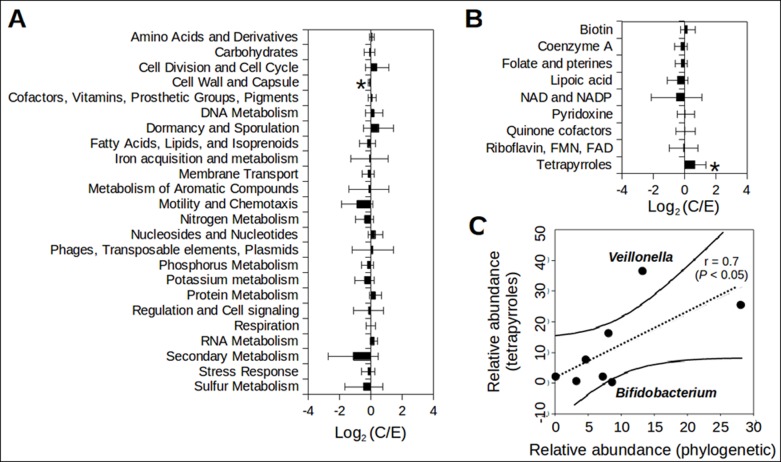
Metabolic pathways differentially abundant between C and E communities.Fold changes of average relative gene abundance assigned to 24 major metabolic categories (A) and the sub-categories related to ‘Cofactors, Vitamins, Prosthetic groups, Pigment’ (B). The bar represents the mean fold change (logarithmic scale) and the error bar represents one standard deviation from the mean. *P < 0.05 by Metastats. (C) Phylogenetic affiliation of the ‘tetrapyrrole’ biosynthesis genes in C communities. The genes related to ‘tetrapyrrole’ were taxonomically classified at genus level based on the best BLASTp search of the amino acid sequences against all available genome sequences in GenBank. The graph shows the relative abundances of the eight major genera (same as in Fig 1B) (x-axis) and the relative abundance of the tetrapyrrole-associated genes encoded by genomes of the eight major genera (y-axis). A Jarque-Bera test did not reject (P > 0.05) the null hypothesis that the ratios (y/x) of the eight genera are normally distributed. The dashed line represents ordinary least squares (OLS) regression, which shows positive correlation (Pearson correlation = 0.7 with P < 0.05). The solid lines represent 95% confidence bands for the OLS slope. The OLS regression analysis was performed using PAST [37]. Note that genomes of Veilonella and Bifidobacterium encoded significantly more or less tetrapyrrole-associated genes than other major genera (i.e., plotted out of the 95% confidence bands).